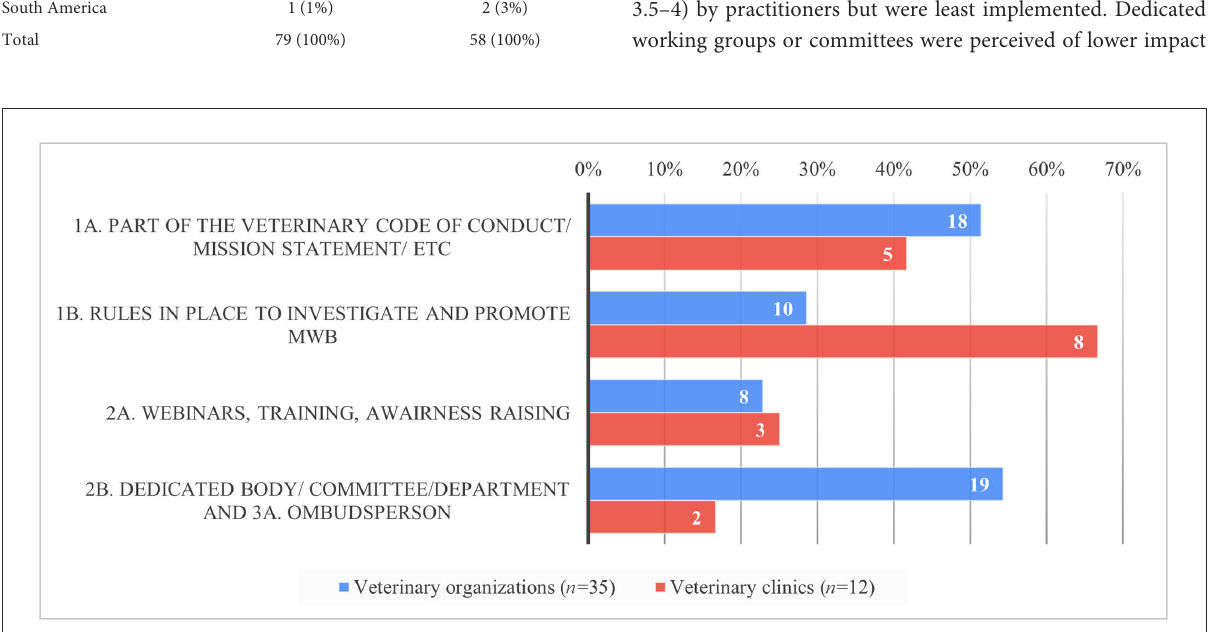
FIGURE3 Relative proportion of MWB strategies implemented per tier and respondent group in per cent ( y -axis) and absolute numbers (inside the bars) based on the survey responses.